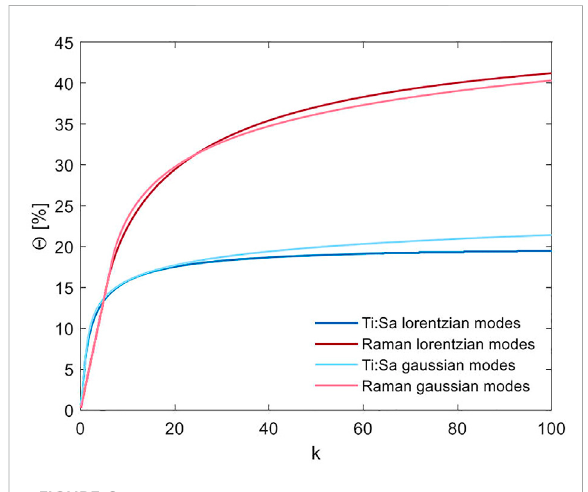
FIGURE 6 Saturation curves simulated by the model based on the overlapofthelaserspectrawiththeDopplerGaussianspectrumof theSmatoms A Sm (rateofionizedatoms)dependingonthescaling factor k that emulates the laser